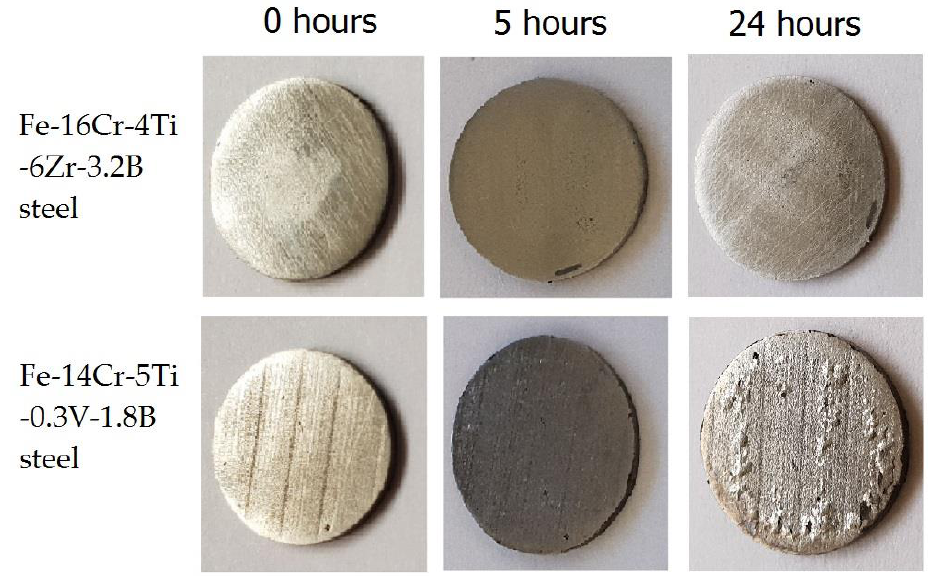
Figure 8. Images of the specimens before and after accelerated corrosion test in the 10% FeCl 3 · 6H 2 O water solution.